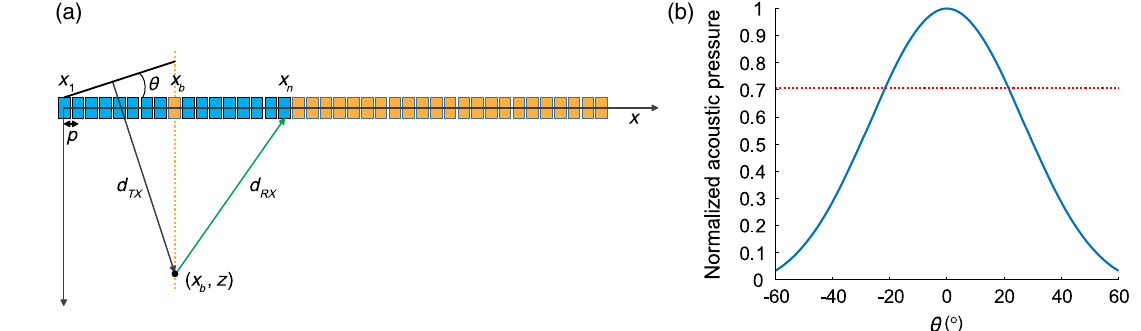
FIG. 7. Linear array aperture geometry and directivity. (a) Ultrasound imaging linear array configuration. Here, θ is the cross- propagation angle, p the pitch of the linear transducer array, x 1 the first element of the active aperture (blue elements), x b the element along the aperture, and x n an arbitrary element along the array. Note that d tx is the distance from the planar wavefront to a point along the bisector, and d rx is the return distance to the array. Silent elements are labeled in orange. (b) Directivity of an individual element of the linear transducer array ( p ¼ 0 . 1 mm, f ¼ 15 . 6 MHz). The red dotted line indicates the − 3 dB acoustic pressure level.